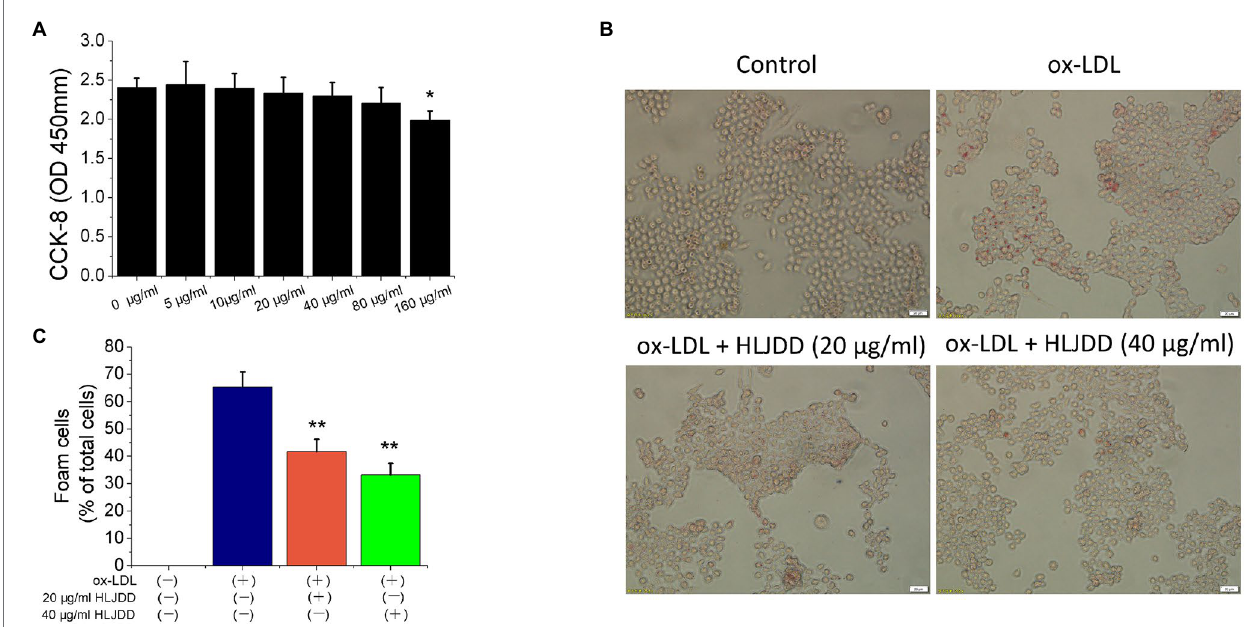
FIGURE 4 | Huang-Lian-Jie-Du decoction inhibited ox-LDL-induced RAW264.7 cells lipid accumulation. (A) Cytotoxicity of HLJDD on RAW264.7 cells. Values are expressed as the mean ± SD from three independent experiments (** p < 0.01 vs. with control group). (B) Representative images of Oil Red O staining in vitro RAW264.7 cells. Scale bar = 20 μ m. (C) Percent positive foam cells were measured by Image J software. Values are expressed as the mean ± SD from three independent experiments (** p < 0.01 vs. ox-LDL-treated group; one-way ANOVA). ox-LDL, oxidized low-density